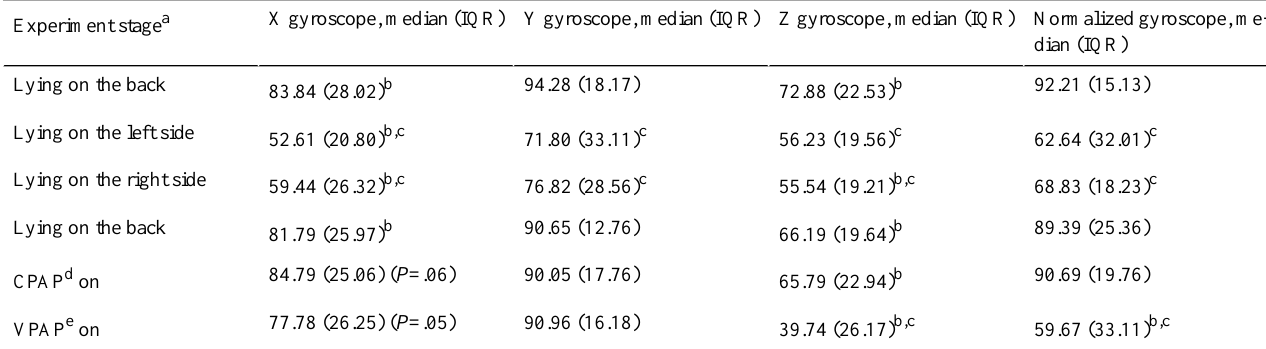
Table 2. Median (IQR) percentage of heartbeats that were correctly identified by the heartbeat detection algorithm.